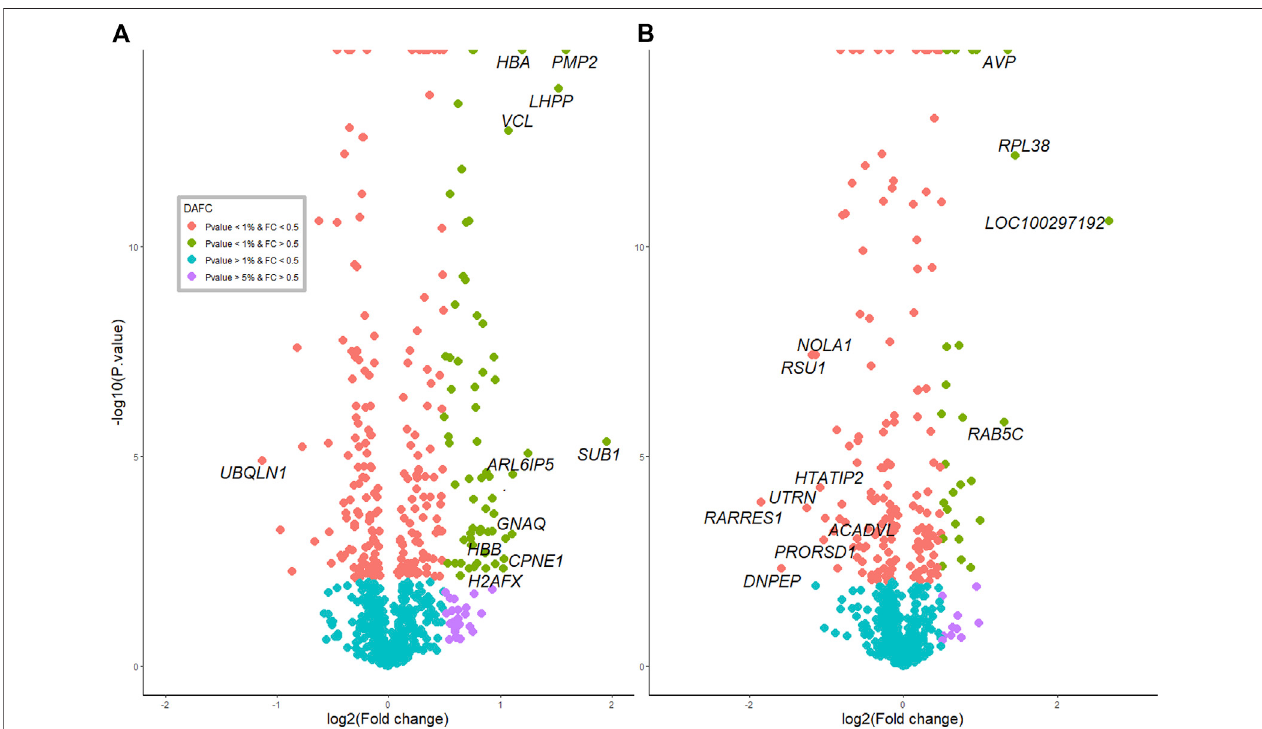
FIGURE2| Proteinpro fi lesandoverlapwithRNAseqbetweenpre-andpostpubertalheifersineachtissue. (A) inthehypothalamustissue. (B) inthepituitarygland.